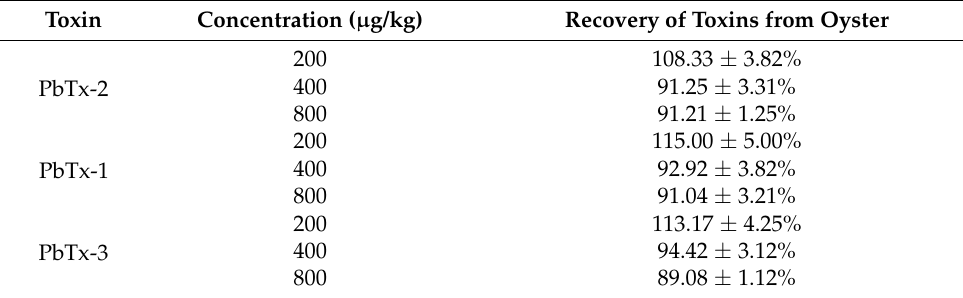
Table 3. Toxin recoveries from spiked oyster samples.